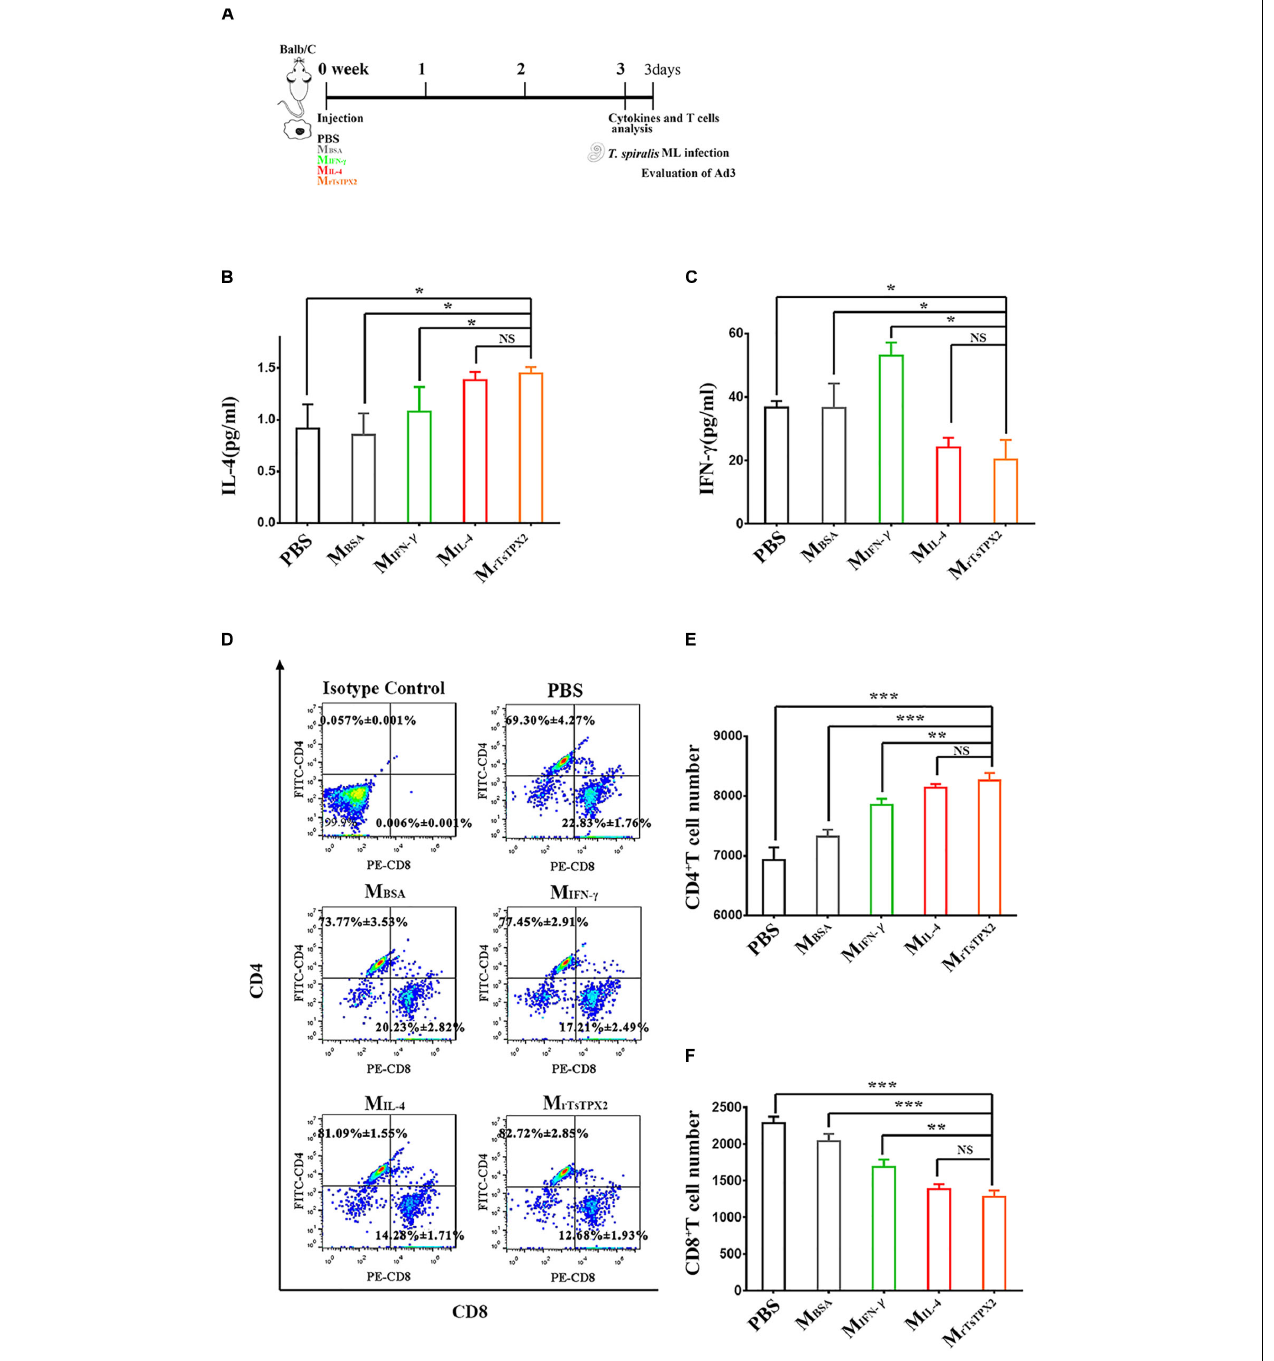
FIGURE 5 | The type of immune responses in mice adoptively transferred with macrophages. (A) Schematics of immune responses in mice adoptively transferred with one of the macrophage types. Three weeks after the first injection, the immunological status was analyzed, and mice were experimentally infected with 500 T. spiralis ML. Analysis of adult load at 3 days after infection. (B) Levels of IL-4 production in sera from mice transferred with various macrophage types. (C) Levels of IFN- γ production in sera from mice transferred with various macrophage types. (D) Analysis of CD3 + CD4 + CD8 − and CD3 + CD8 + CD4 − T lymphocytes. The number on the representative contour plots showing the ratio of each subset out of peripheral lymphocytes. (E) The total number of CD3 + CD4 + CD8 − T cells in blood from mice. (F) The total number of CD3 + CD8 + CD4 − T cells in blood from mice. Experimental groups include mice transferred with macrophages activation by IL-4 as M2 positive control (M IL − 4 ), INF- γ as M1 positive control (M INF − γ ), BSA as mock control (M BSA ) or rTsTPX2 (M rTsTPX2 ). The experimental group, PBS representative mice, injected with PBS. Statistical analysis was performed with Student’s t -test, and data are presented mean ± SDs (representative of three experiments). *** P < 0.001, **0.001 < P < 0.01, *0.01 < P < 0.05, NS, not significant. n > = 3 mice per